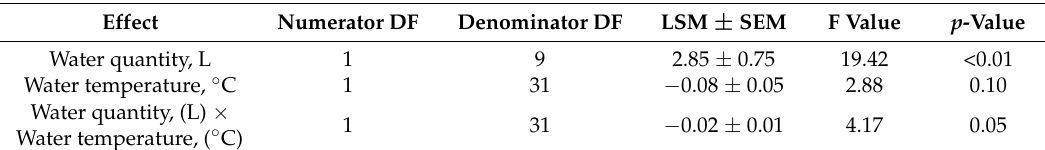
Table 3. Experiment part 2: Effect of water quantity (5.7 L, 11.4 L, 22.7 L), water temperature (1.7 ◦ C, 7.2 ◦ C, 15.6 ◦ C and 29.4 ◦ C) and their interaction using a linear mixed model investigating the maximum degrees ( ◦ C) dropped in reticuloruminal temperature for feed restricted, once daily drenched pregnant cows ( n = 12).